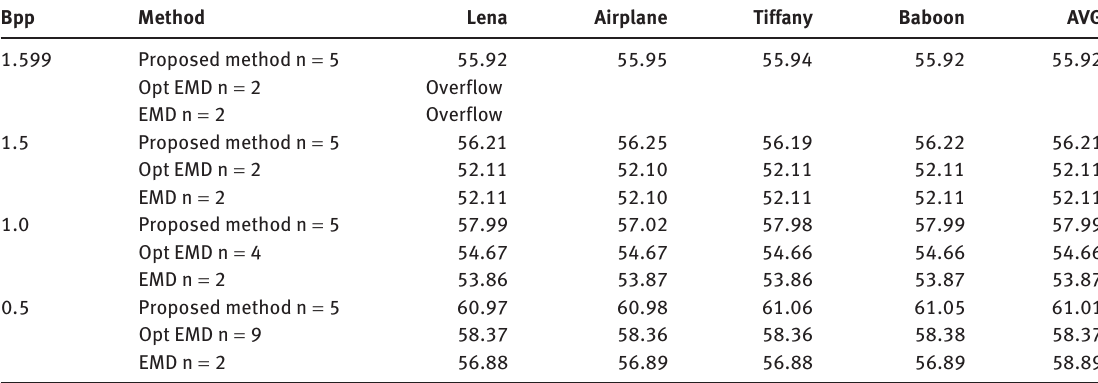
Table 1. Performance of the Proposed Method against both EMD and Optimized EMD.